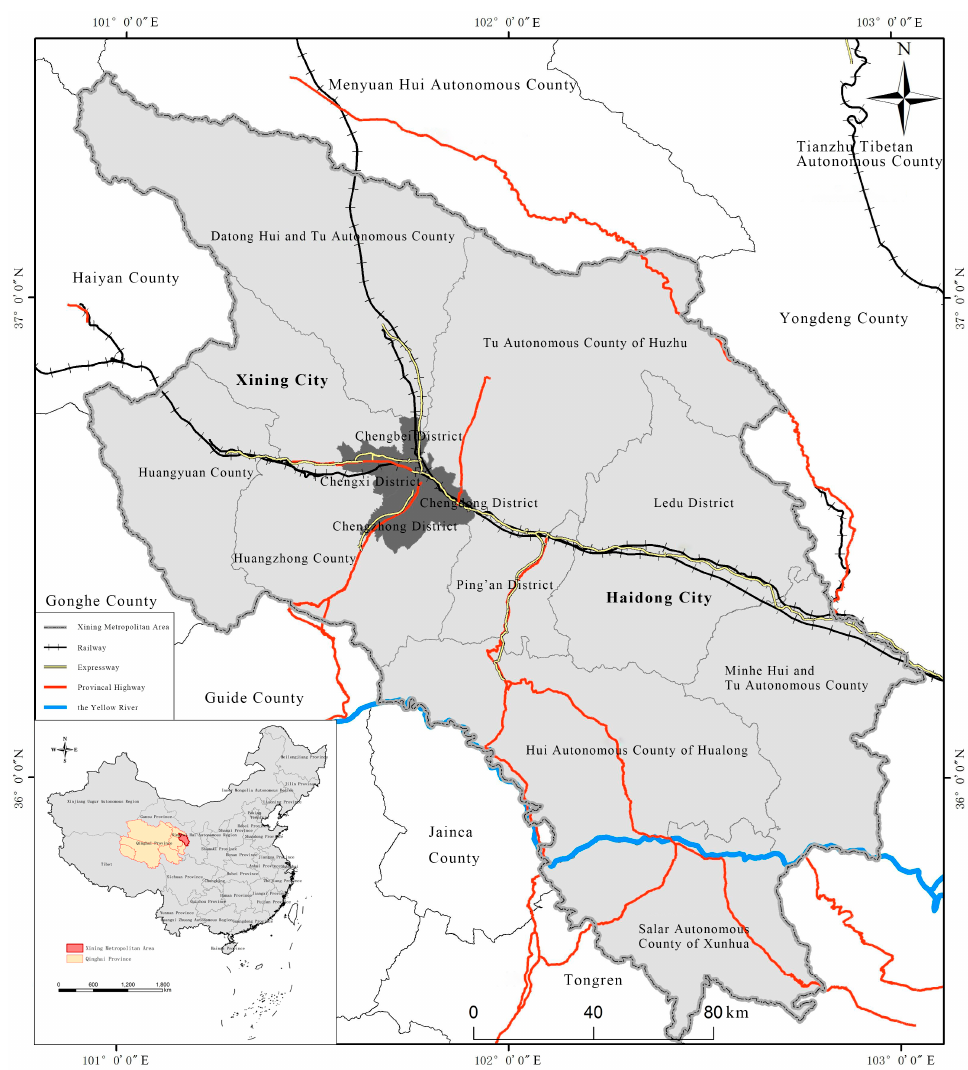
Figure 1. Location and Administrative Division of the XMA.